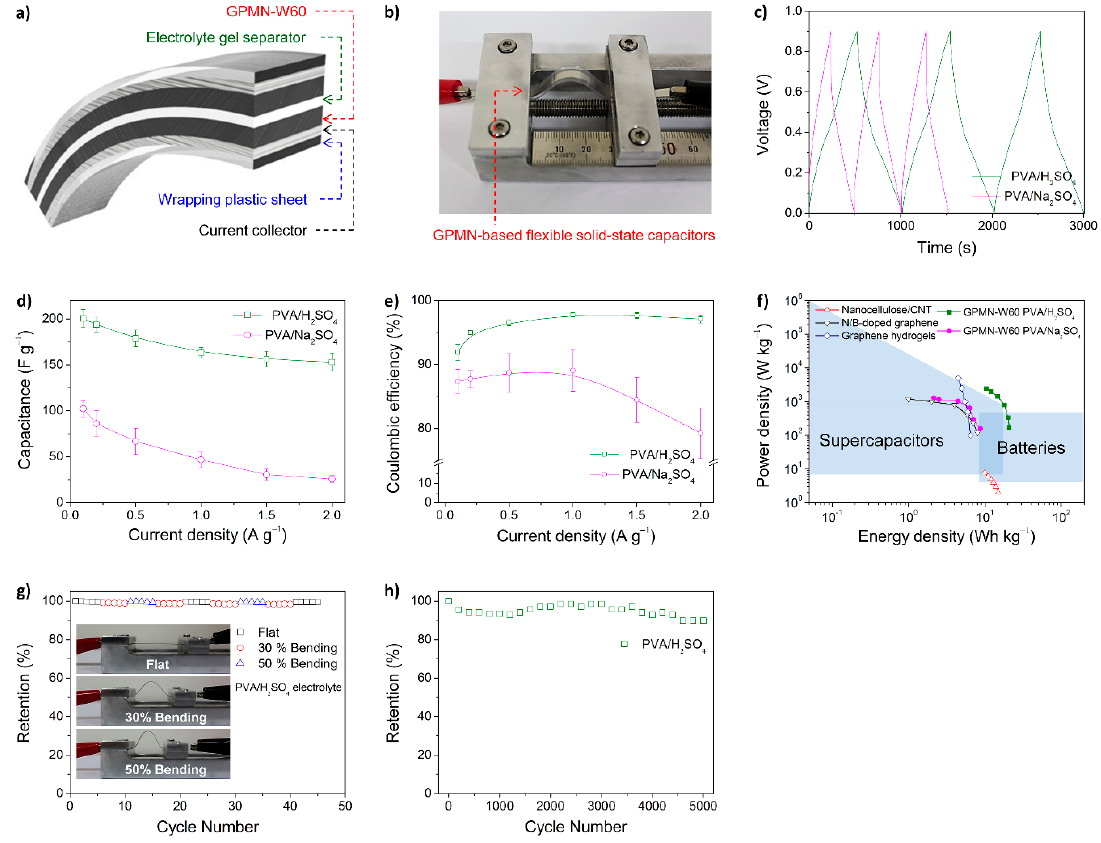
Figure 14. Flexible, all-solid-state graphene/PANI-glue multilayered nanostructure cells: ( a ) schematic of an all-solid-state flexible electrochemical capacitor cell; ( b ) typical photograph of cell performance measurement under mechanical deformation; ( c ) galvanostatic charge–discharge curves at a current density of 0.1 A·g − 1 for different electrolytes; ( d ) specific capacitances as a function of current density; ( e ) coulombic efficiency as a function of current density; ( f ) Ragone plots; ( g ) capacitance as a function of bend radii; and ( h ) long-term cycling stability of the cell with an acidic electrolyte. Reprinted with permission from [45]. Copyright 2015, John Wiley & Sons Inc.